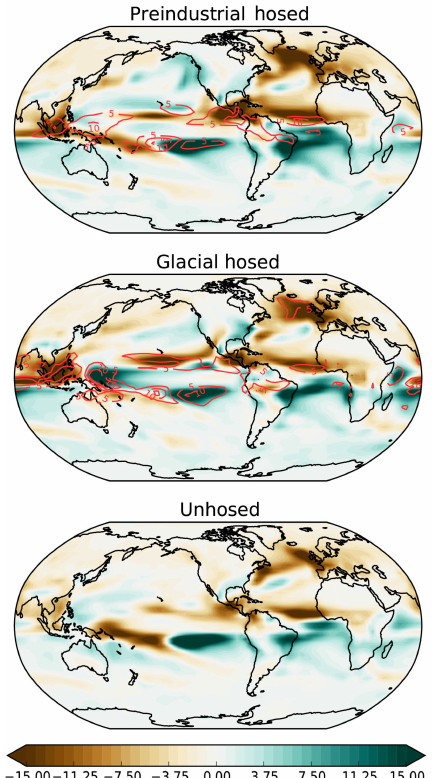
Figure 6. Stadial surface air temperature anomaly. The top two pan- els show the surface air temperature difference between weak and strong AMOC states (as defined in Fig. 3) under preindustrial and glacial boundary conditions, averaged between the four sets of or- bital configurations (see Fig. S2 to view all eight hosing simulations individually). Red contours show the standard deviation between the four sets of orbital configurations at 1 ◦ C intervals. The bottom panel shows the surface air temperature difference between weak and strong AMOC states (as defined in Fig. 3) in the unhosed sim- ulation. Shading and contours in ◦ C.